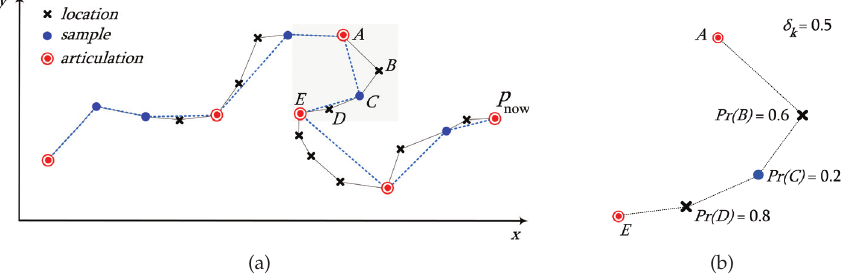
Figure 5: Scaling with random sampling: (a) Chosen articulation points and random sam- ples. (b) Taking samples with probability ≤ δ k once frame W k